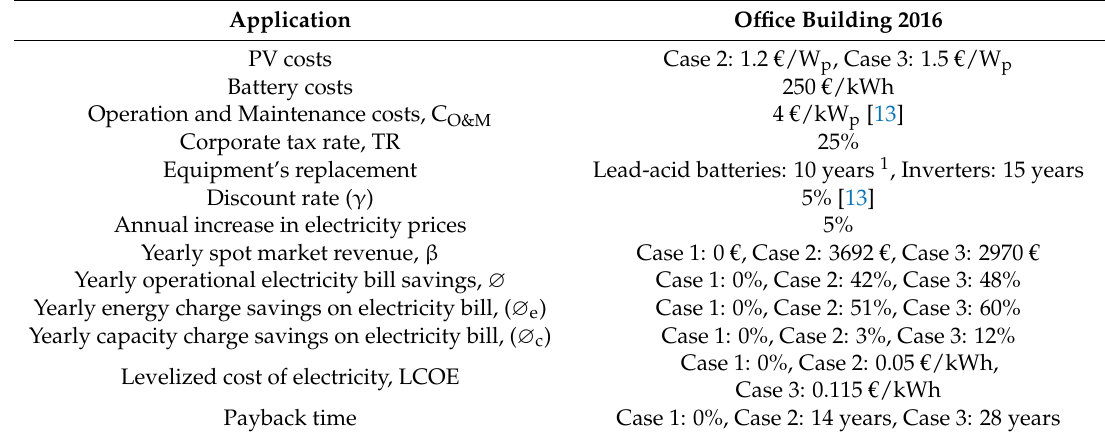
Table 7. Economic analysis: cost structure, investment assumptions and